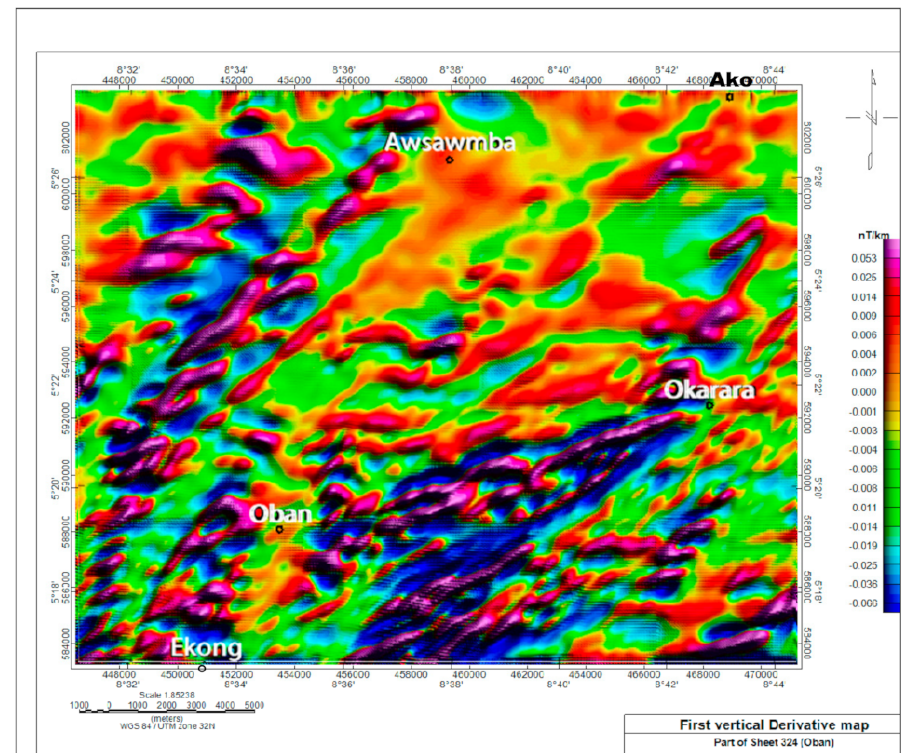
Figure 11. First vertical derivative